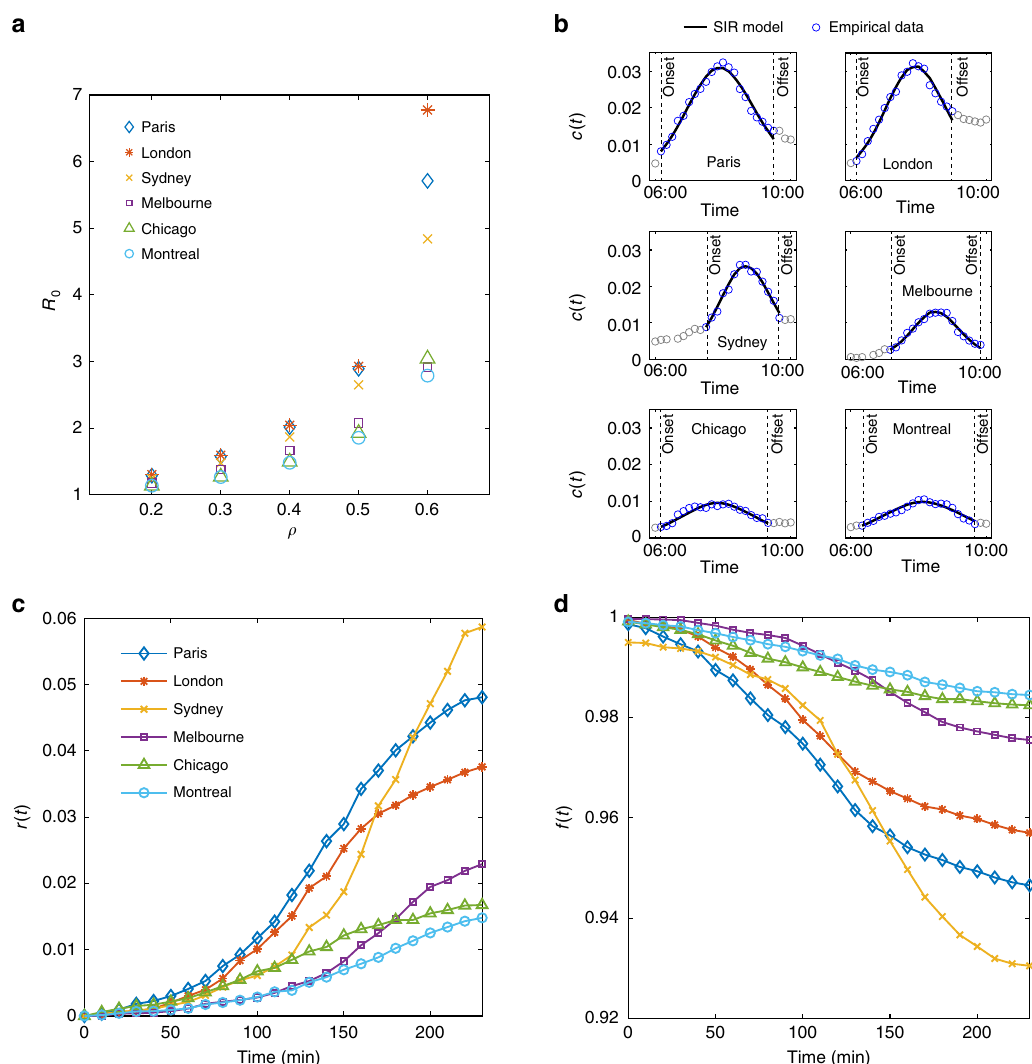
Fig. 3 Empirical evidence on the congestion propagation and dissipation dynamics from six different cities. a Relationship between R 0 and ρ . For smaller values of ρ , there is a consistency in the observed dynamics across different cities despite their differences in network structure, demand, and traf fi c patterns. R 0 remains roughly invariant for the same value of ρ for smaller ρ values, suggesting the existence of a universal measure for congestion propagation; b proportion of congested links in the network over time c ( t ) for each city from 6:00 to 10:00 a.m. when ρ = 0.2. Congestion onset and offset is marked with dashed lines. Note that the y -axis has a fi xed range [0, 0.035] and a subset of data between the congestion onset and offset times are utilized to fi t the SIR model; c evolution of fraction of recovered links r ( t ) in the network over time; d evolution of the fraction of free fl ow links f ( t ) in the network over